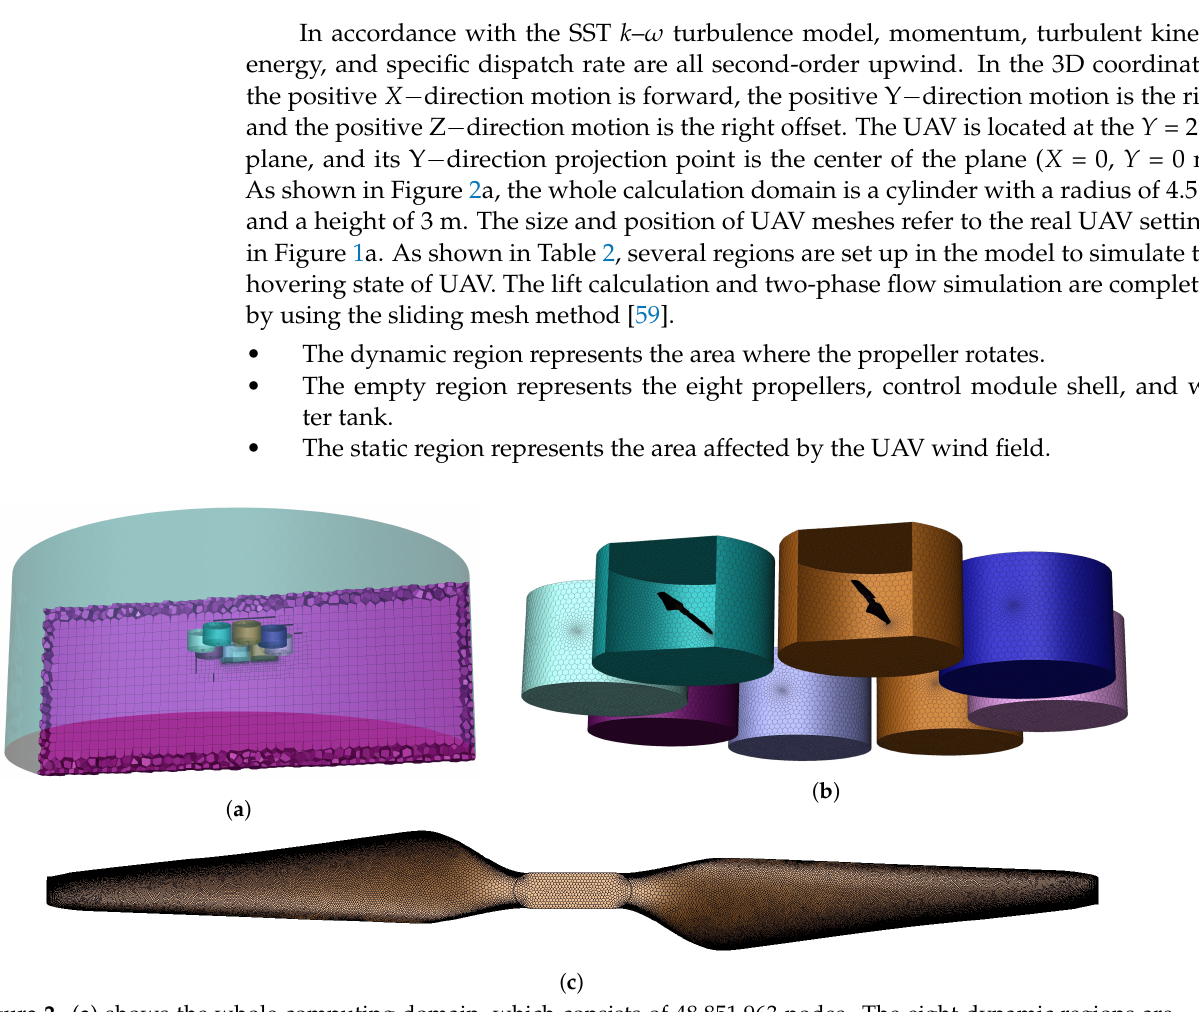
Figure 2. ( a ) shows the whole computing domain, which consists of 48,851,963 nodes. The eight dynamic regions are shown in ( b ). ( c ) shows the propeller, which consists of approximately 4900 surfaces. The interface meshes are refined for accurate